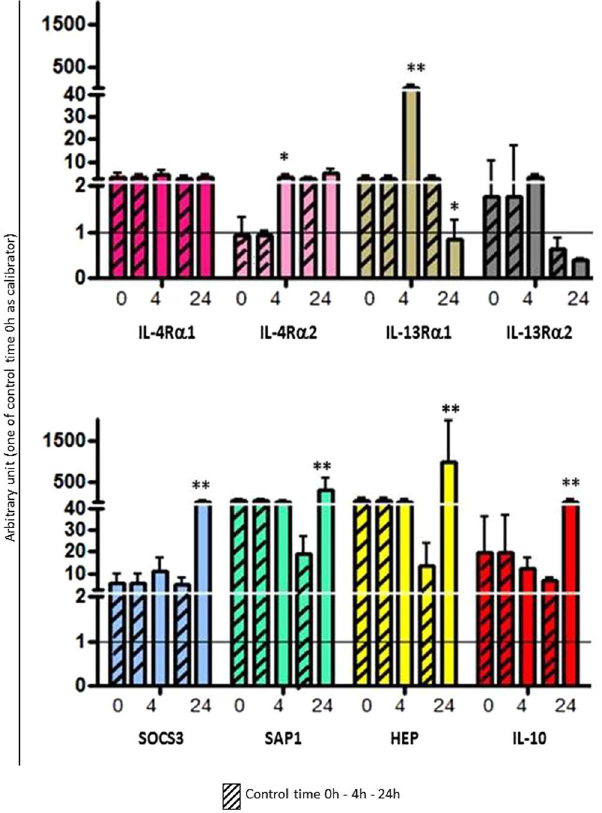
Figure 7. Biological activity of sea bass recombinant IL-4/13A2. The expression level of genes coding for IL- 4R α 1, IL-4R α 2, IL-13R α 1, IL-13R α 2, SOCS3, SAP1, HEP and IL-10 was determined in HK leukocytes after stimulation with the sea bass recombinant IL-4/13A2. Transcription values were expressed as a ratio relative to 18S rRNA in the same samples. The quantitative PCR amplification was performed in PCR arrays and each point represents the mean + SD of cells from 4 individual fish. * p < 0.05 with respect to the time 0 control; ** p < 0.01 with respect to the time 0